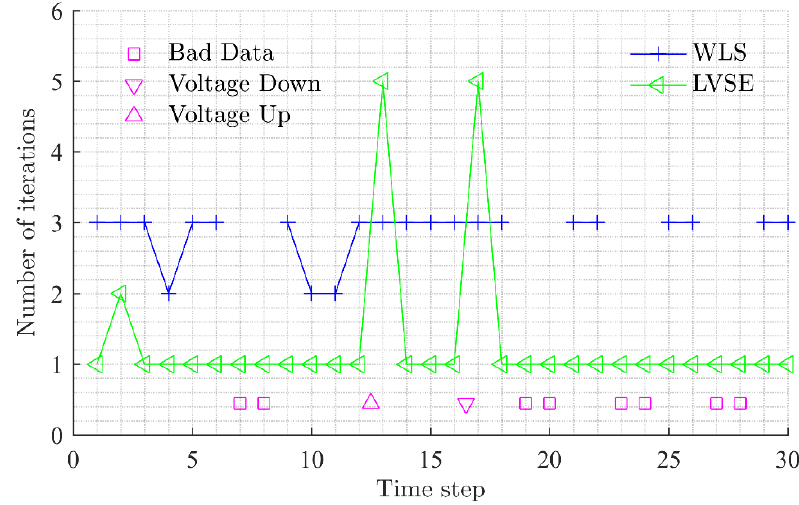
Figure 11. Number of iterations per step.